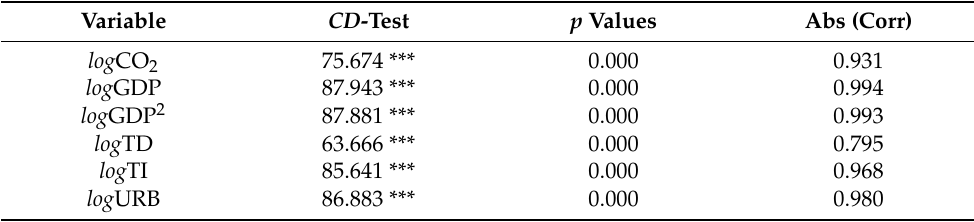
Table 4. Correlation dependence test.